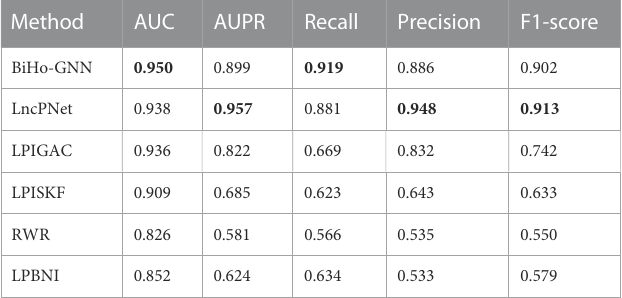
TABLE 2 Performance comparison of lncRNA-protein interaction